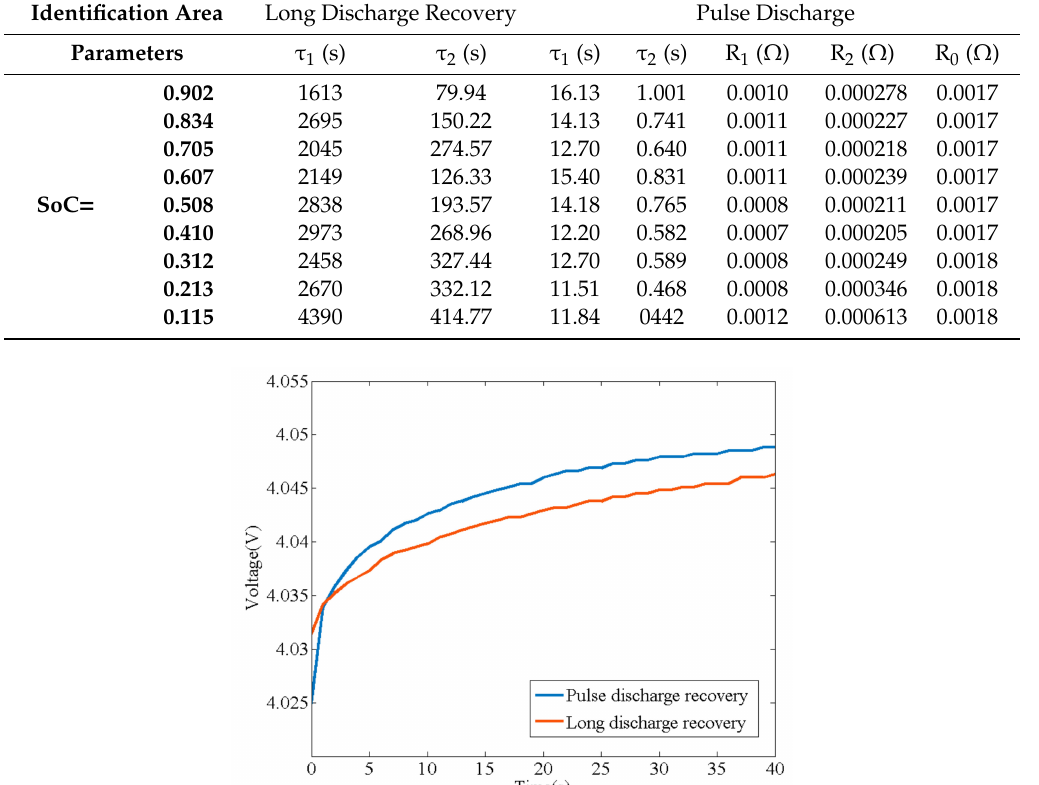
Table 3. Identification results of RC parameters.